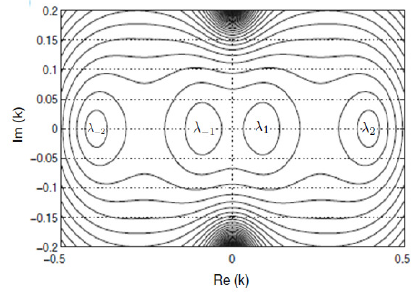
Figure 3. Contour plot of roots of the dispersion relation